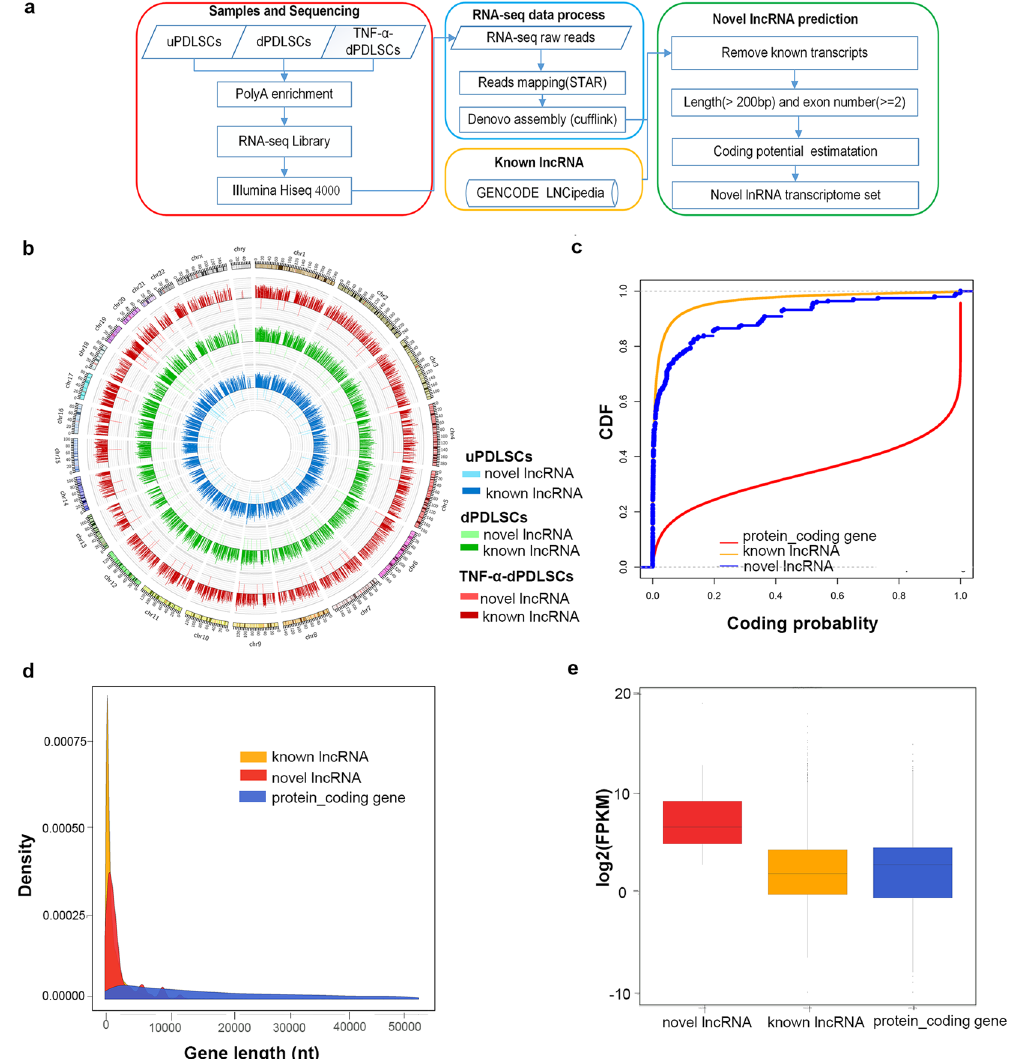
Figure 2. Systematic identification of lncRNAs in PDLSCs. ( a ) The pipeline for the identification of novel lncRNAs. ( b ) Circos plot showing the lncRNA profiling in PDLSCs. Each circle represents a PDLSC subset (from inner to outer: uPDLSCs, dPDLSCs and TNF- α -dPDLSCs). For each circle, the inside bars represent novel lncRNAs and the outside bars represent known lncRNAs. ( c ) Coding potential of transcripts from the entire dataset, estimated using CPAT algorithm. ( d ) Length distribution of protein-coding genes, known lncRNAs and novel lncRNAs. ( e ) Expression abundance of protein-coding genes, known lncRNAs and novel